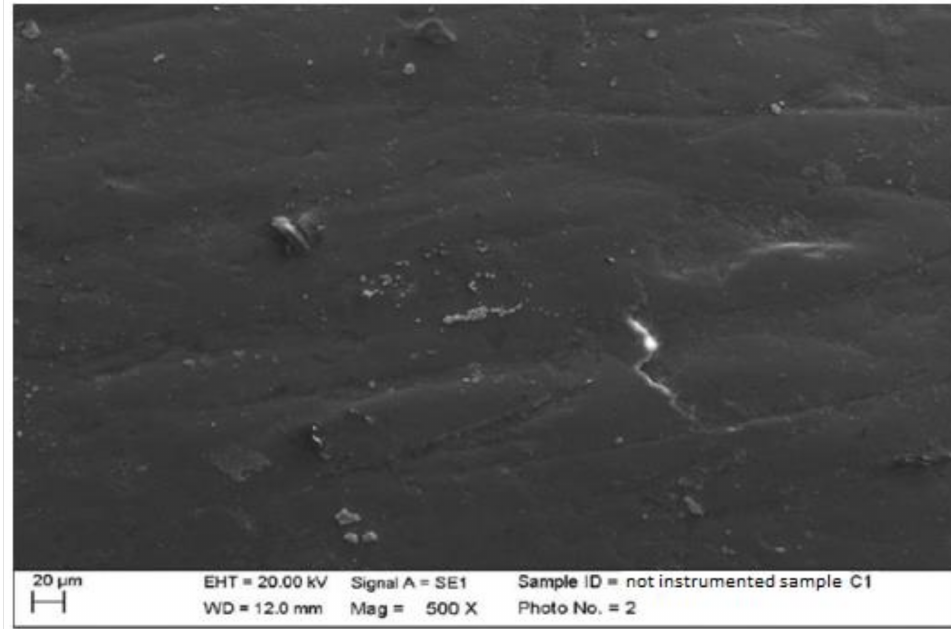
Figure 1. Non-instrumented composite sample C1 (500 × ).